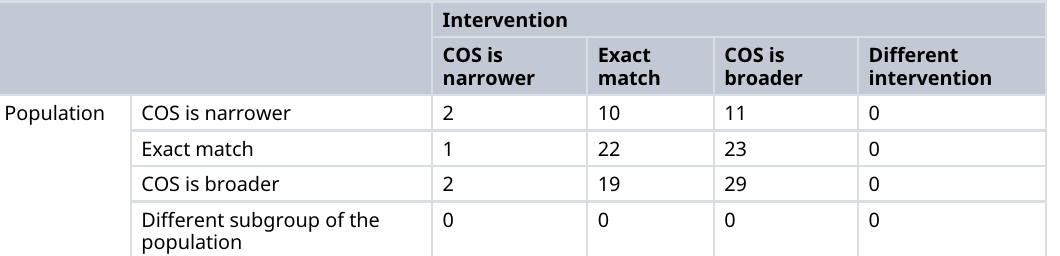
Table 5. The scope of HTAs compared to the COS regards population and intervention.